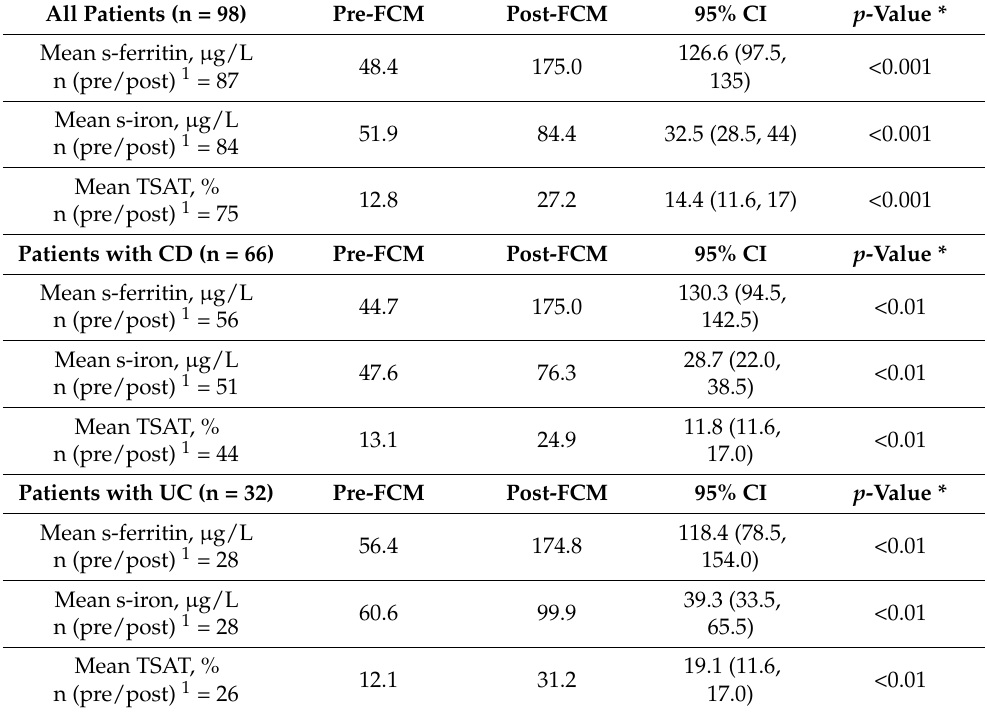
Table 2. Effects of ferric carboxymaltose administration on iron